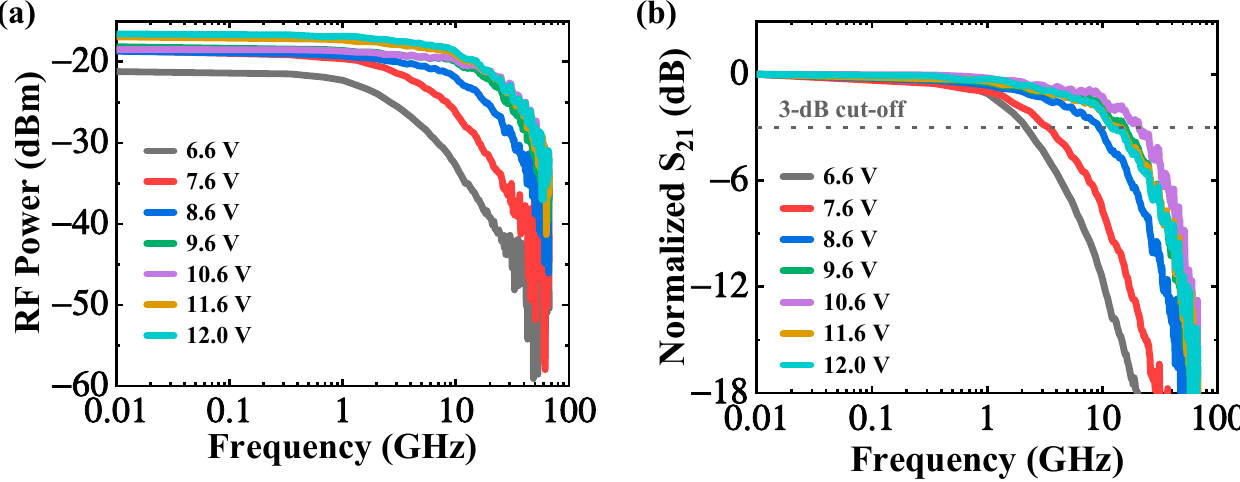
Figure 8. ( a ) The measured RF power under different voltages; ( b ) the normalized S21 parameter at different voltages.